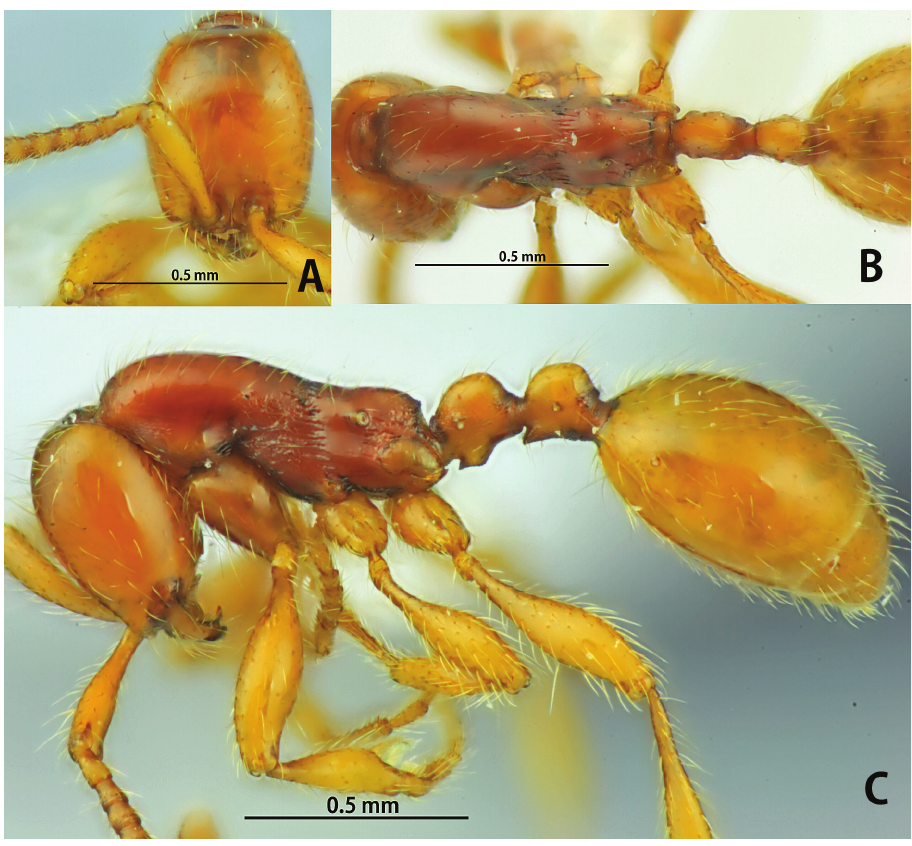
Figure 2. Aenictus baliensis (holotype). A Head in full-face view B body in dorsal view C body in groove; mesopleuron relatively long, demarcated from metapleuron by indistinct groove; metapleural gland bulla relatively large, its maximum diameter about 2.4 times as long as distance between propodeal spiracle and metapleural gland bulla. Propodeum in profile with feebly convex dorsal outline; propodeal junction angulate, nearly right-angled; de- clivity of propodeum widely and shallowly concave, encircled with a rim. Petiole slightly longer than high, with its dorsal outline convex; subpetiolar process low and subrectan- gular. Postpetiole shorter than petiole, with its dorsal outline roundly convex. Head including mandible and antennal scape entirely smooth and shiny. Prome- sonotum smooth and shiny except for anteriormost portion punctate; propodeal dor- sum and metapleuron smooth and shiny; mesopleuron and lateral face of propodeum shagreened; petiole entirely smooth and shiny except for lateral face superficially re- ticulate; postpetiole smooth and shiny. Head and mesosoma dorsally with relatively dense standing hairs; longest pronotal hair 0.15–0.18 mm long. Head, petiole, gaster, and legs yellowish brown; mesosoma reddish brown.